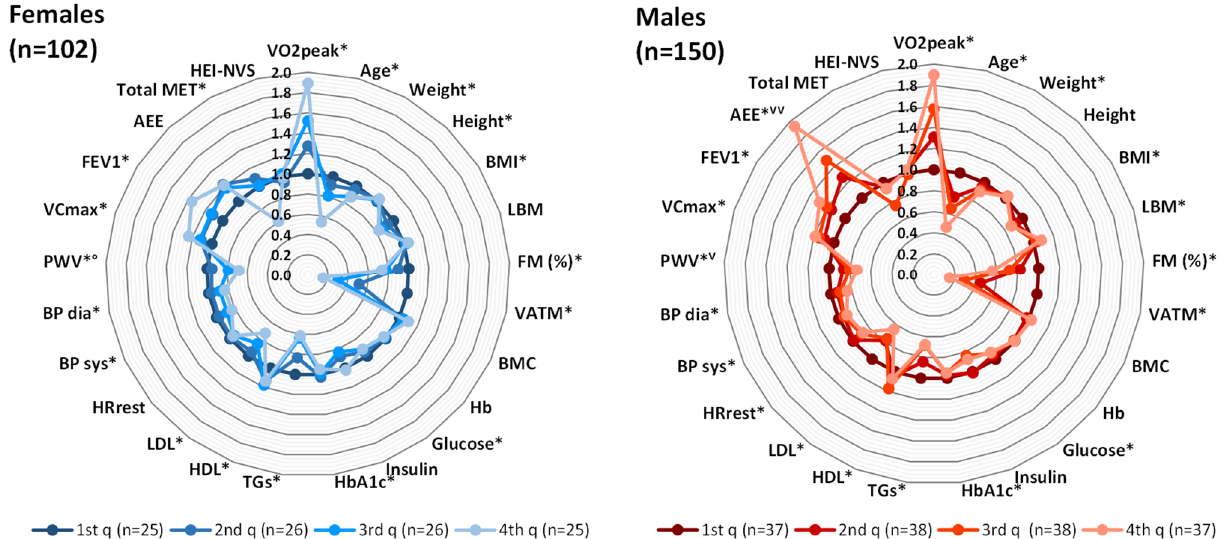
Figure 1. Radar plots visualizing the basic characteristics of KarMeN participants according to sex-specific VO 2peak quarters. The means of the 1st q were used as reference values to the means of the 2nd, 3rd and 4th q. *: significant differences between quarters according to the Welch ANOVA. ◦ : n = 23 (1st q), n = 25 (2nd q); V : n = 36 (1st q); VV : n = 35 (1st q), n =